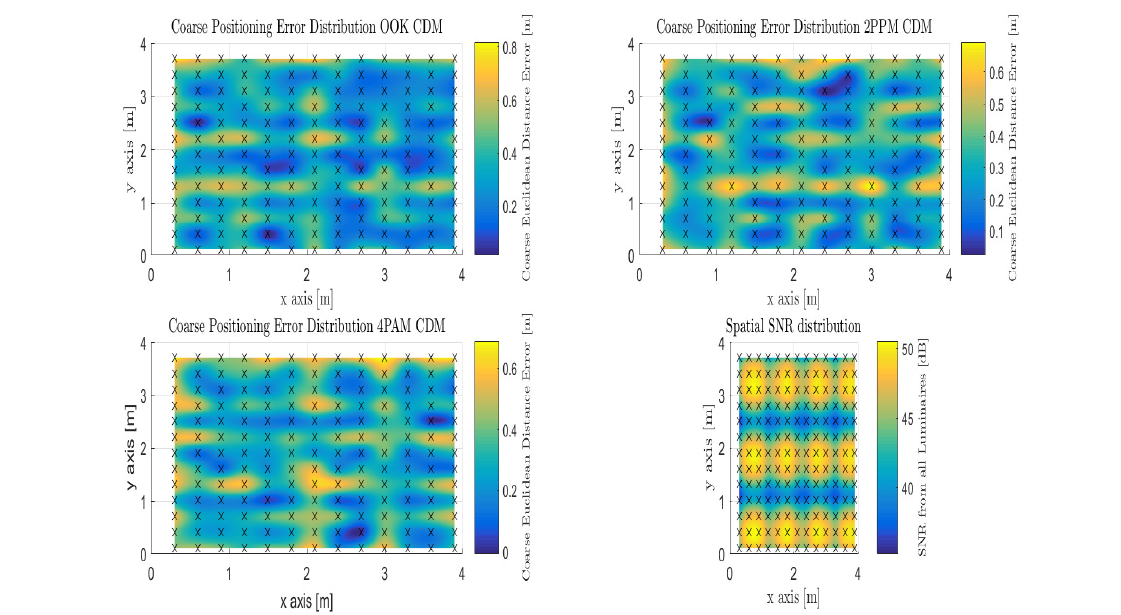
Figure 10. Illustration of Coarse Proximity-based Positioning with Code Division Multiplexing for OOK, 2-PPM, and 4-PAM pulsed modulations under the Spatial SNR Room